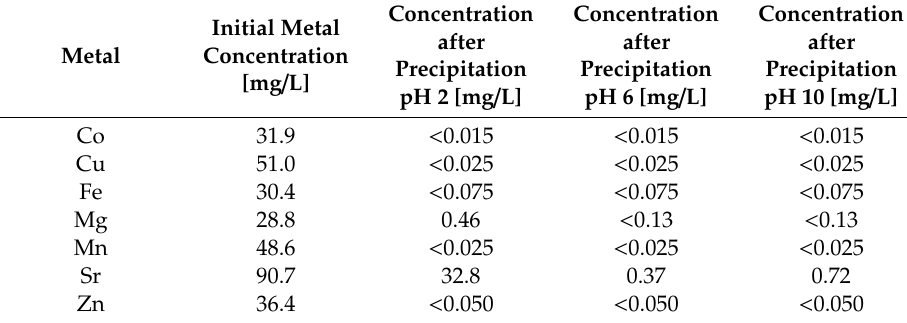
Table 3. Precipitation of some selected metals with Na 2 S.